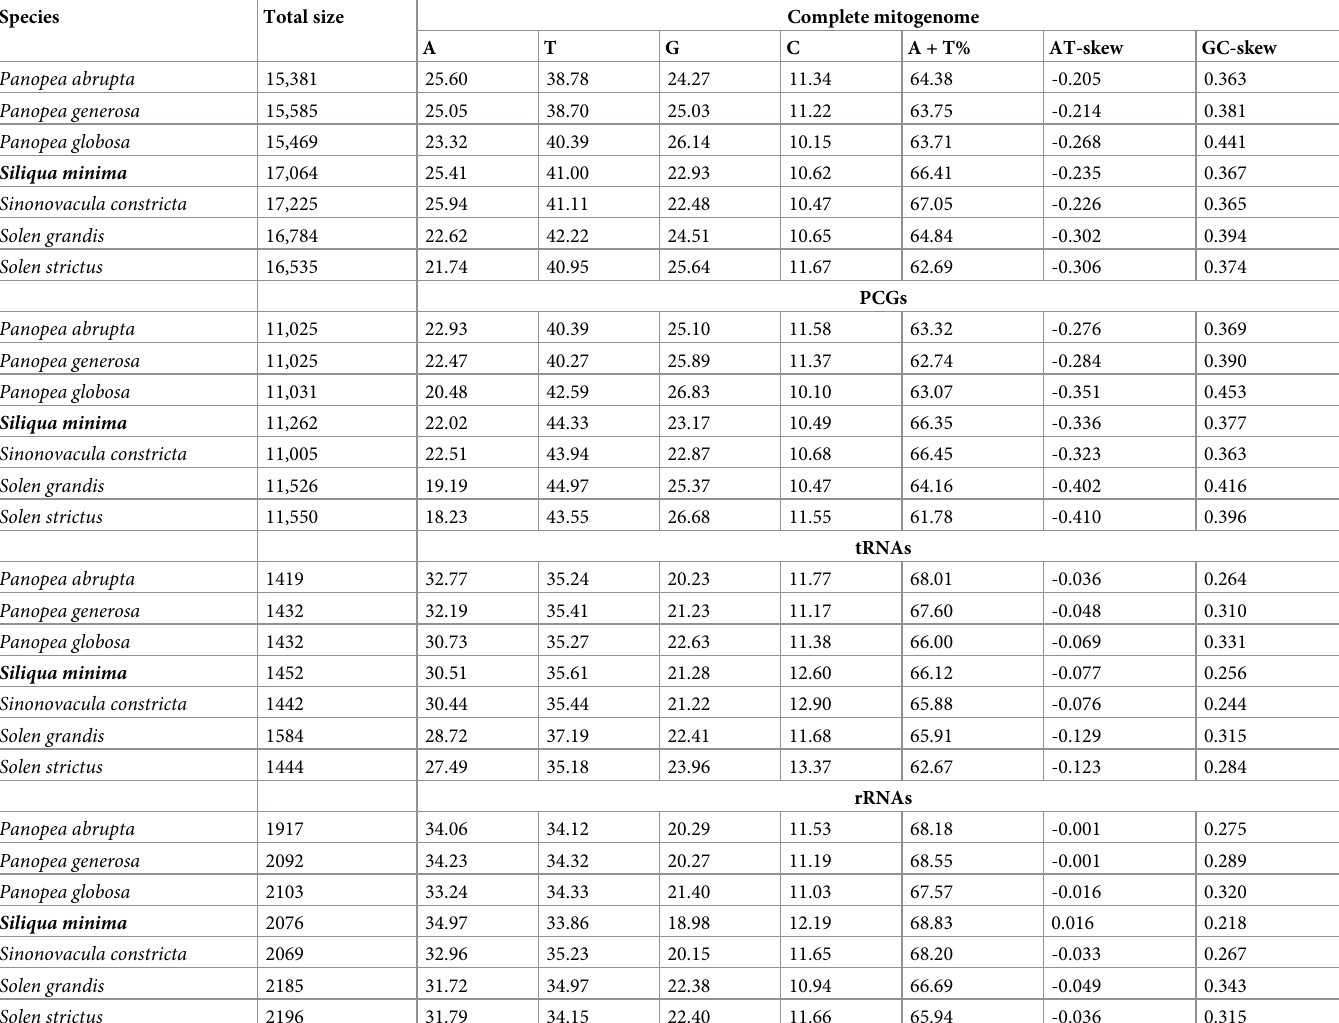
Table 4. Nucleotide composition in regions of the mitogenomes of seven Adapedonta